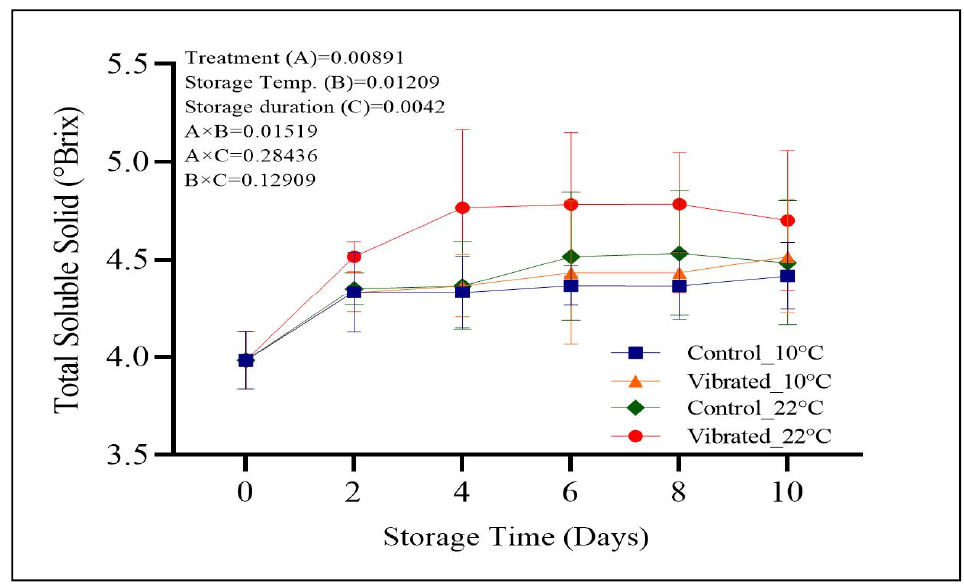
Figure 12. TSS value (Brix°) value of vibrated and non-vibrated (control) tomatoes stored at 10 °C and 22 °C for 10 days storage. Error bars represent the standard deviation(SD) of the mean values ± S.D 6 readings per 3 replicates.